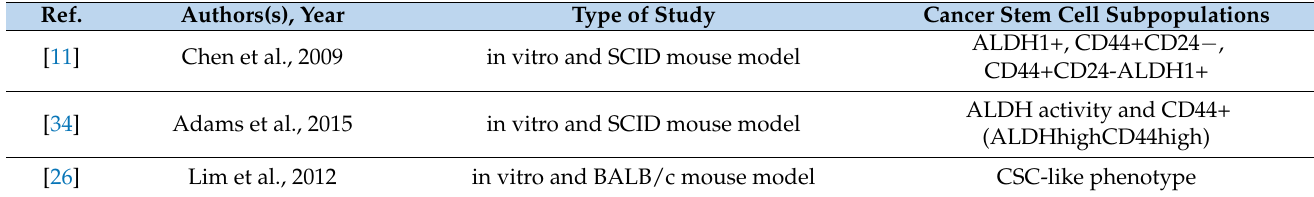
Table 1. Enhanced tumorigenic properties of Head and Neck Cancer Stem Cells. Experimental findings supporting the enhanced self-renewal, proliferative, and tumorigenic potential of head and neck cancer stem cells.